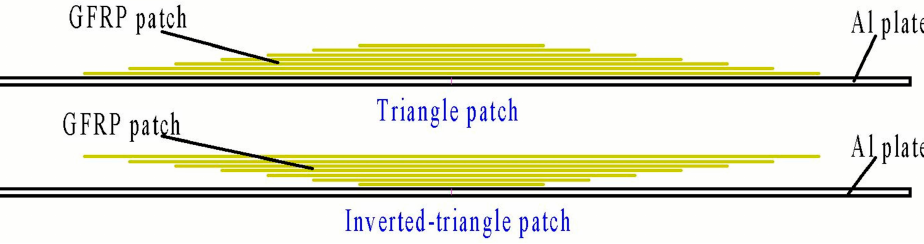
Figure 2. The repair configuration of the single-sided external patch.